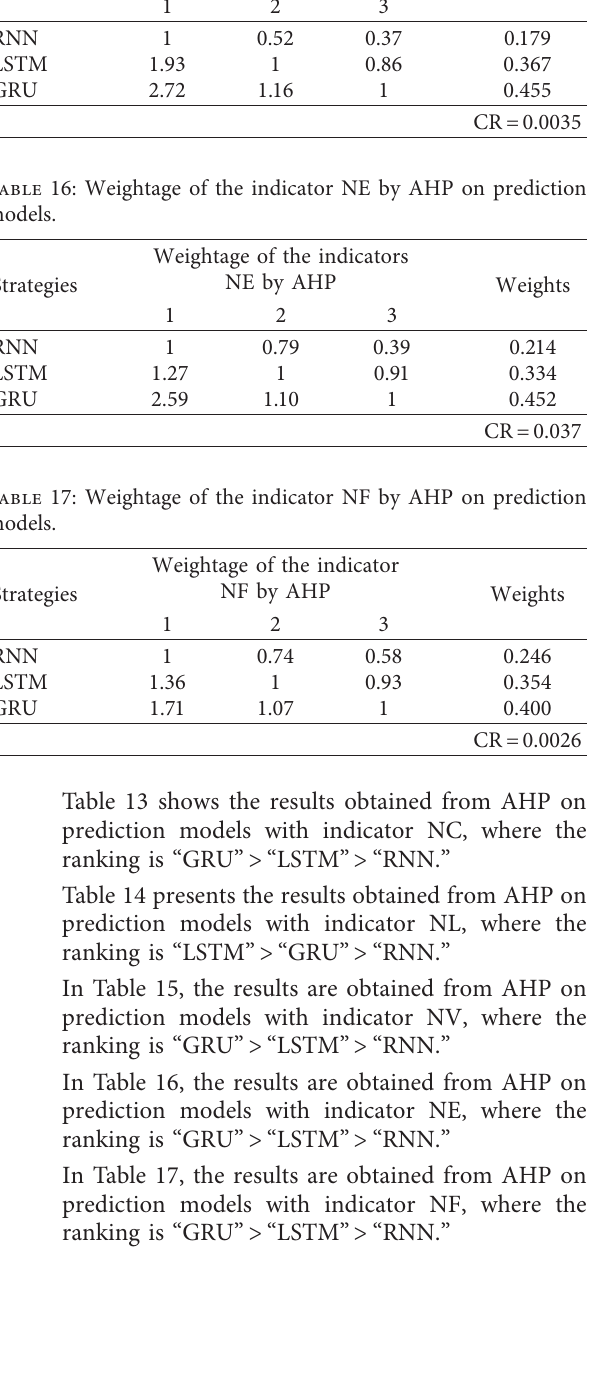
Table 15: Weightage of the indicator NV by AHP on prediction models. Weightage of the indicators NV by AHP Strategies